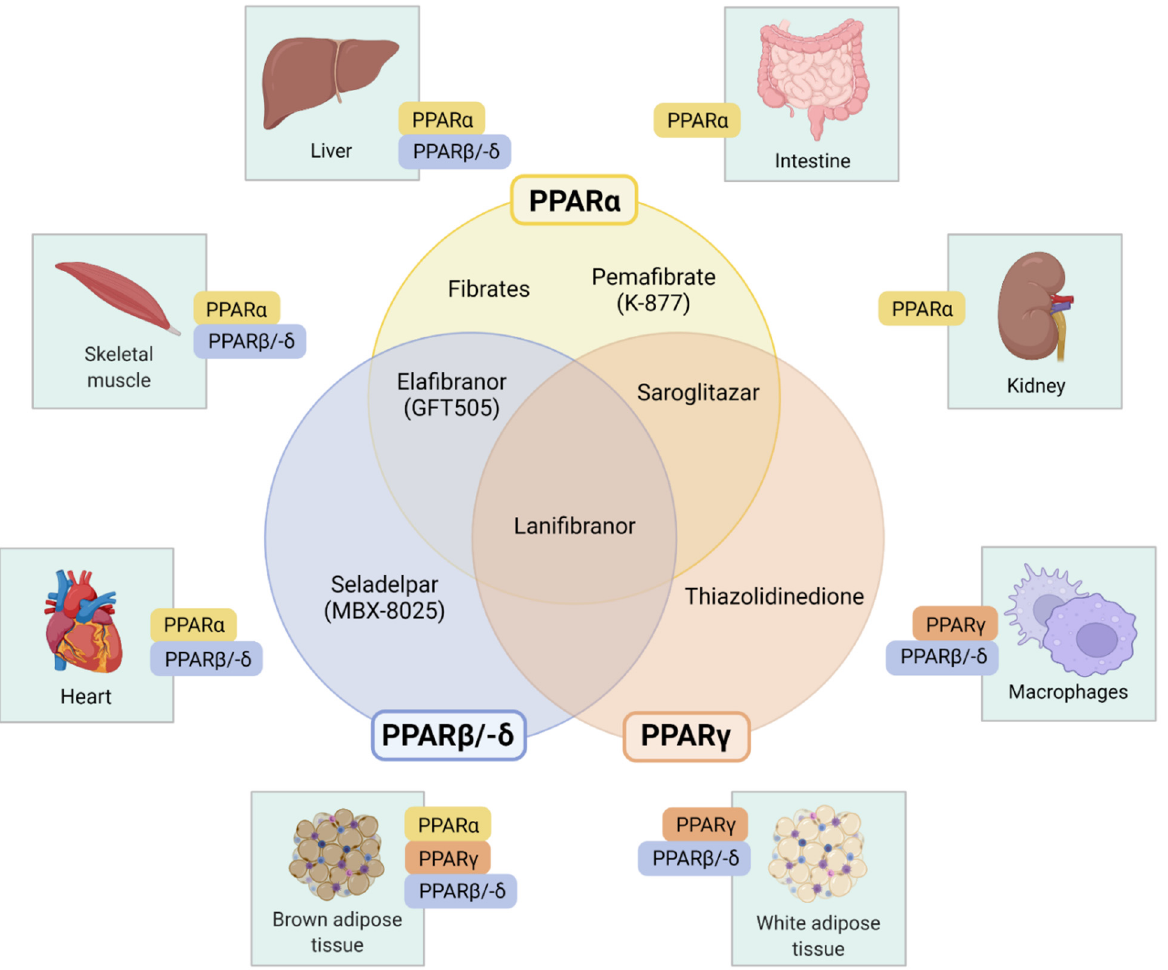
Figure 2. Overview of respective receptor profile of PPAR-modulating agents used in clinical trials and main tissue distribution of PPAR isotypes. Created with BioRender.com.